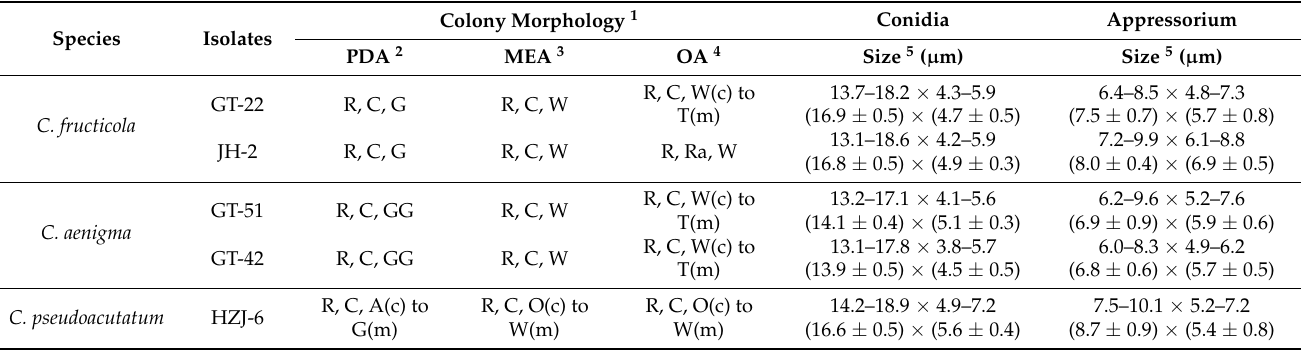
1 Surface of colony: R, regular; C, circular; G, gray; GG, gray-green; A, atrovirens; W, white; O, orange; T, trans- parent; Ra, radiation; c, center; m, margin. 2 Potato dextrose agar. 3 Malt extracts agar. 4 Oatmeal agar. 5 Length × Width (data are mean ± standard